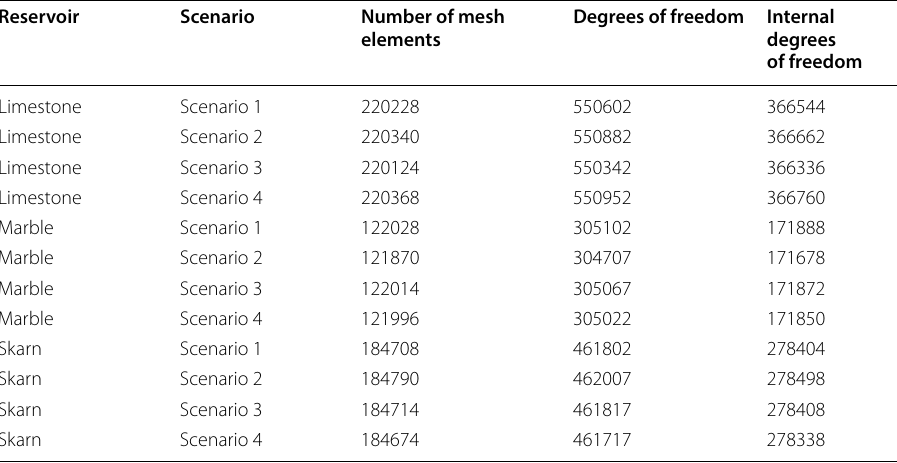
Table 4 Number of elements in mesh and degrees of freedom Reservoir